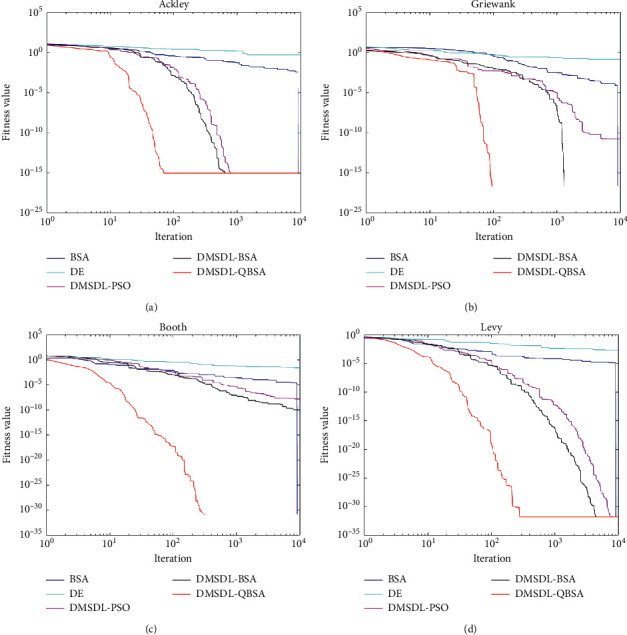
Fitness value curves of 5 hybrid algorithms on (a)f12; (b)f13; (c)f17; and (d)f18 (Dim = 2).